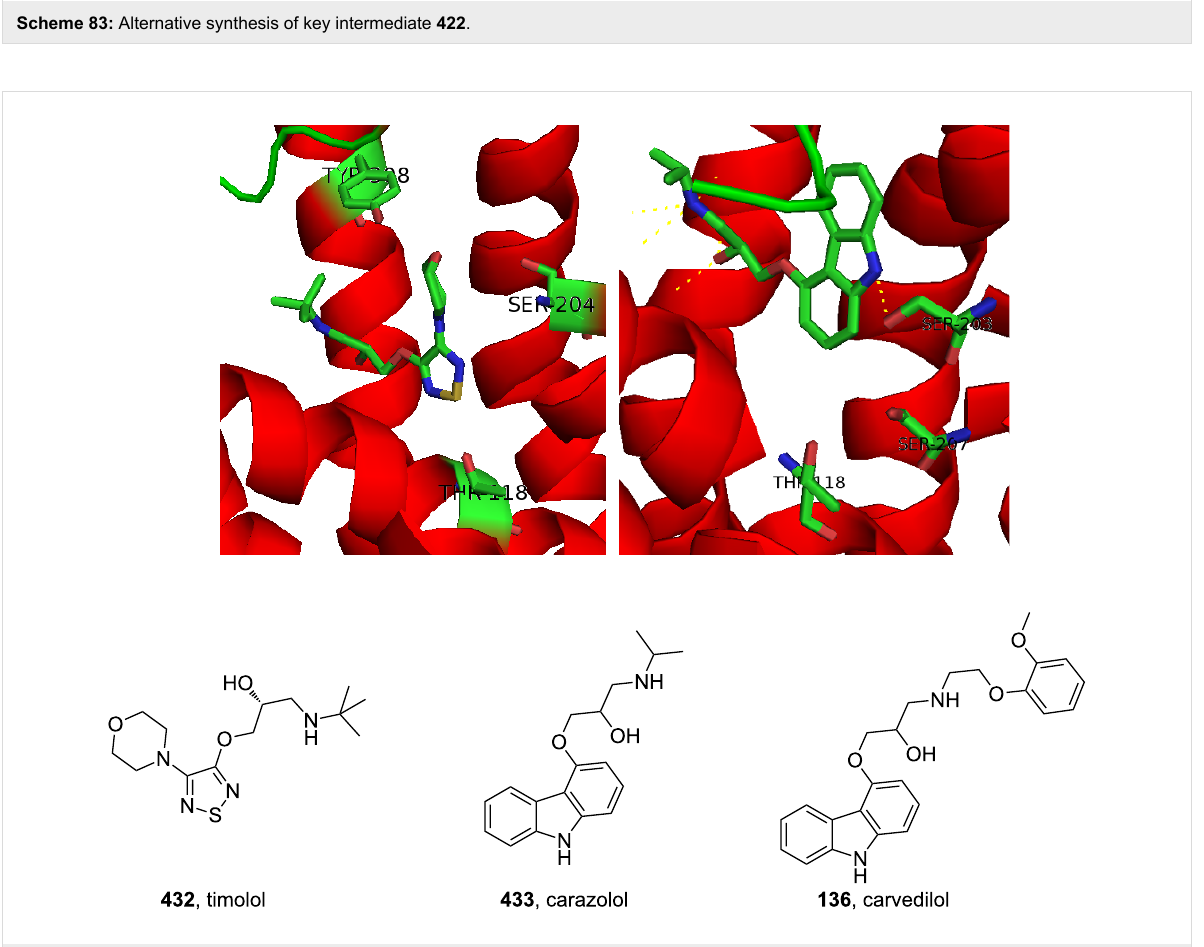
Figure 14: Co-crystal structures of timolol (left) and carazolol (right) in the β -adrenergic